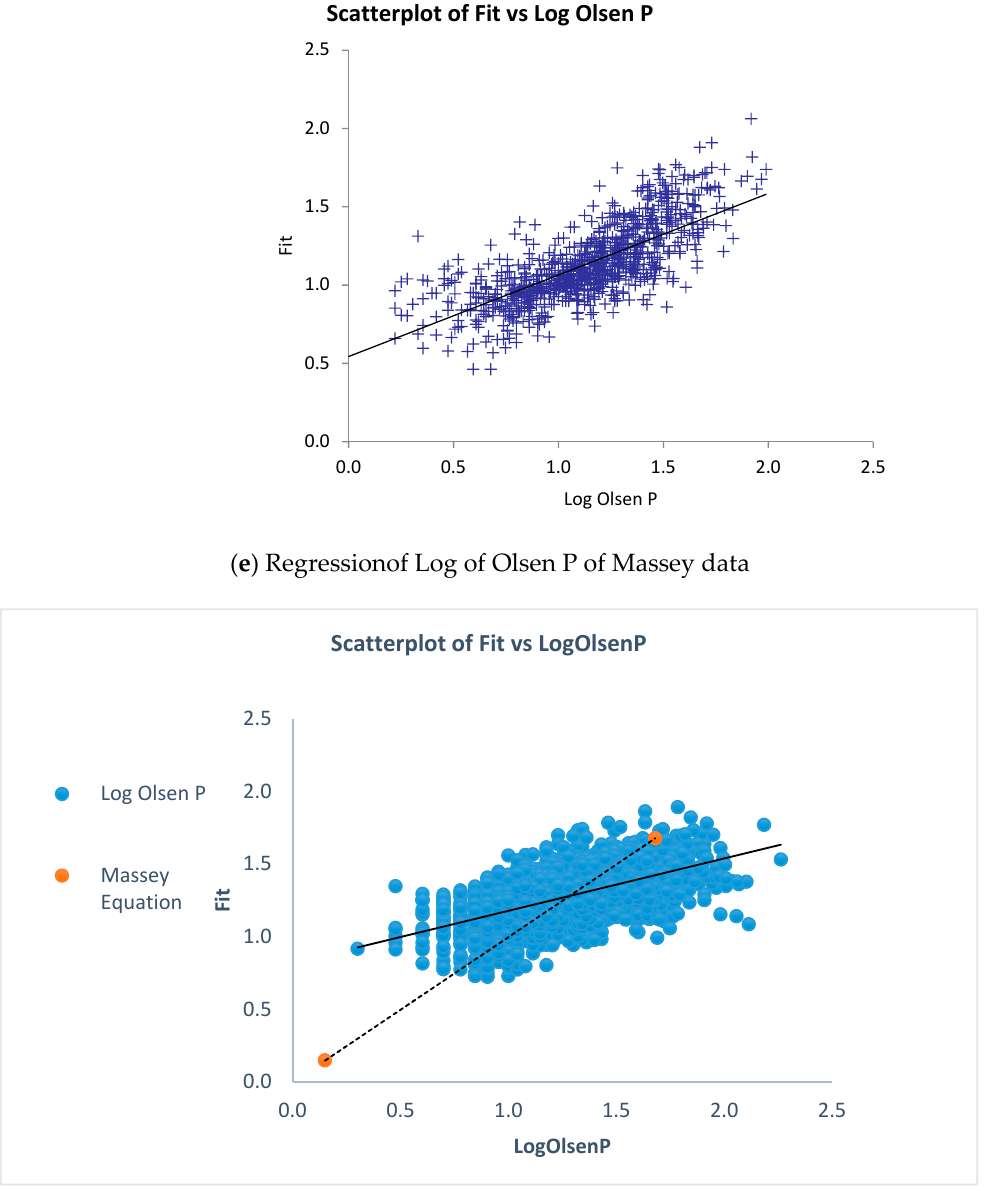
( f ) Regression of Log of Olsen P of Ravensdown data and Ravensdown data using the Massey Log Figure 5. Scatter plots of Olsen P and pH modelled results compared to measured, for ( a , b ) Massey calibration set and ( c – f ) application of the Massey model to the Ravensdown set of data for validation and comparison to the data set regression.